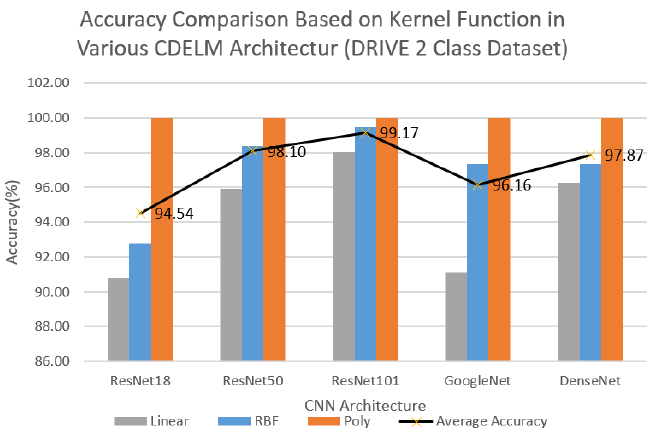
Figure 10. Results of Experiment on 2-class DRIVE Dataset.